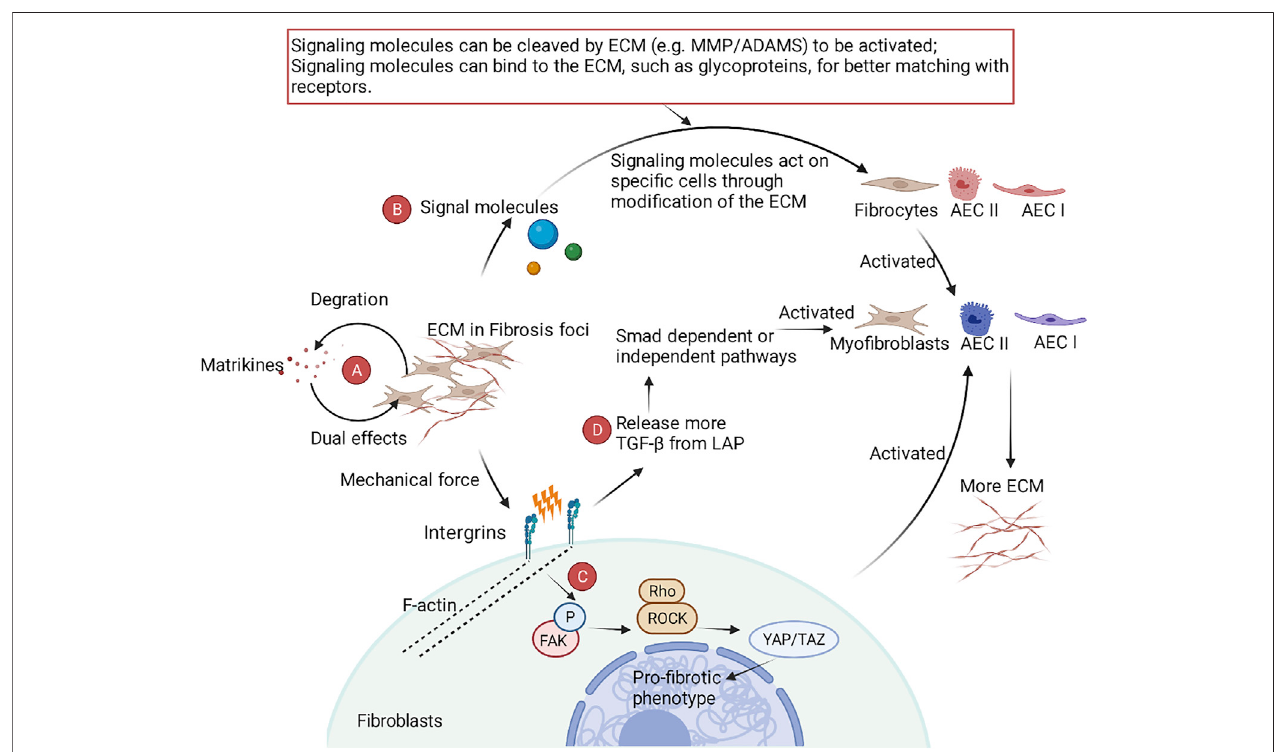
FIGURE 3 | A schematic view of the role of ECM in IPF. (A) Matrkines, which contain multiple degradation products of the ECM, exert dual pro- and anti- fi brotic roles in IPF. (B) The ECM is involved in the phenotypic reprogramming of fi broblasts and AECs by modifying key signaling molecules. (C) After binding speci fi c ECM ligandstotheectodomainofintegrins,integrinsbindtothecytoskeletonandvarioussignalingproteinsthroughtheircytoplasmictails,translatingthemechanicalforceof cytoskeleton contraction and ECM stiffness into biochemical signals. (D) Integrins activate TGF- β -dependent fi brosis by releasing TGF- β through stretch force generated by actin-cytoskeleton